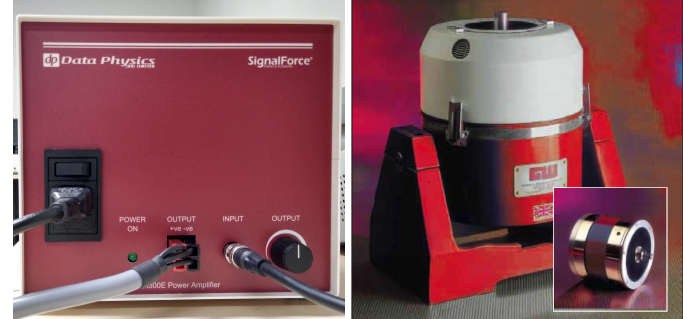
Figure 3. Amplifier model PA300E (left) and inertial shaker IV47 series (right) from Data Physics used in the experimental